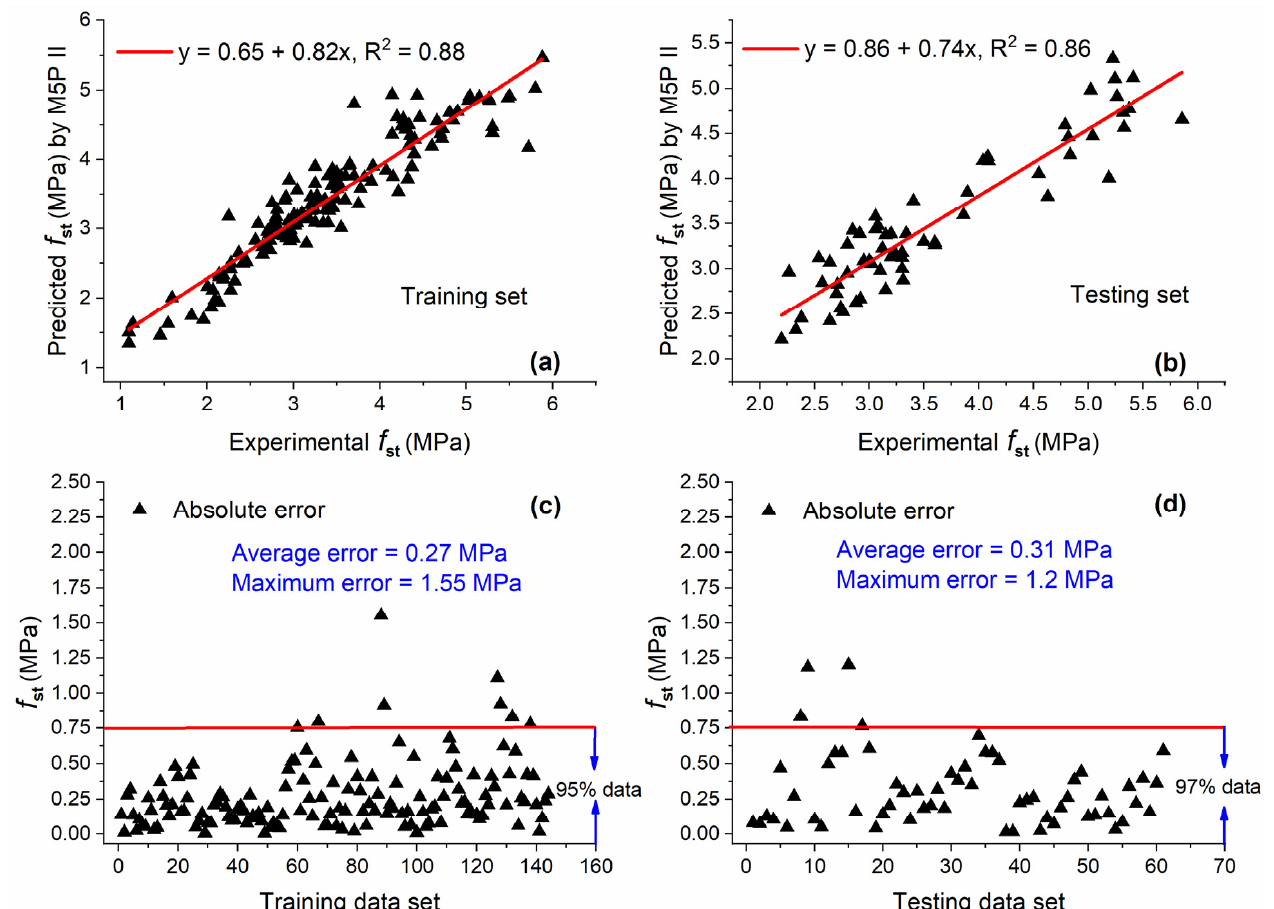
Figure 15. Experimental and predicted values of f st by M5P II for ( a ) training set and ( b ) testing set, and their corresponding absolute error for ( c ) training data set and ( d ) testing data set.